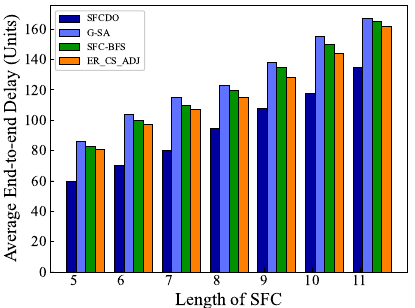
Figure 6. Average end-to-end delay of SFCs in large topology.